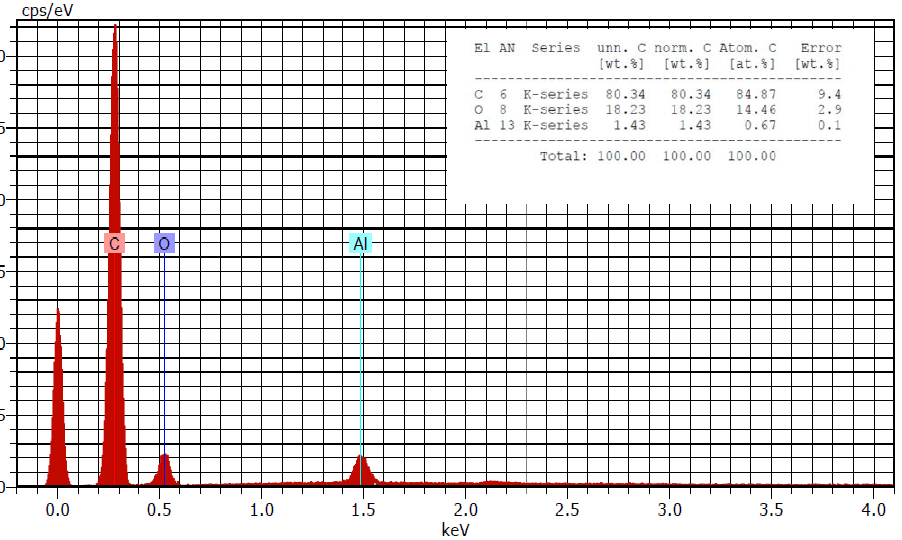
Figure 7. SEM/EDX analysis of particles collected in filters during the abrasion process. Elements identifed: carbon (C), oxygen (O) and aluminium (Al).